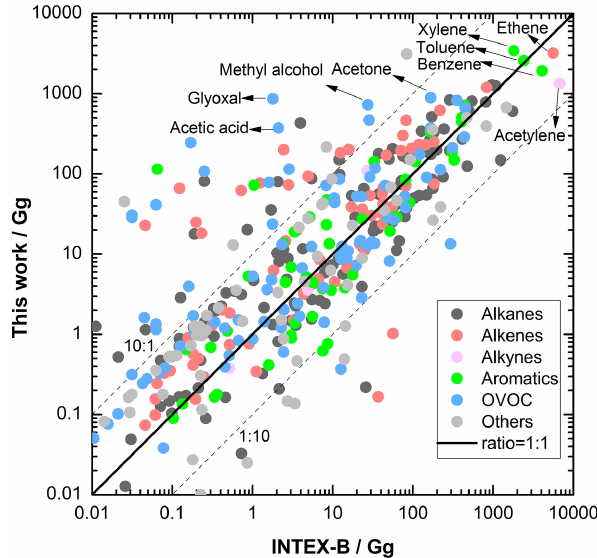
Figure 6. Comparison of this work and the INTEX-B inventory by individual